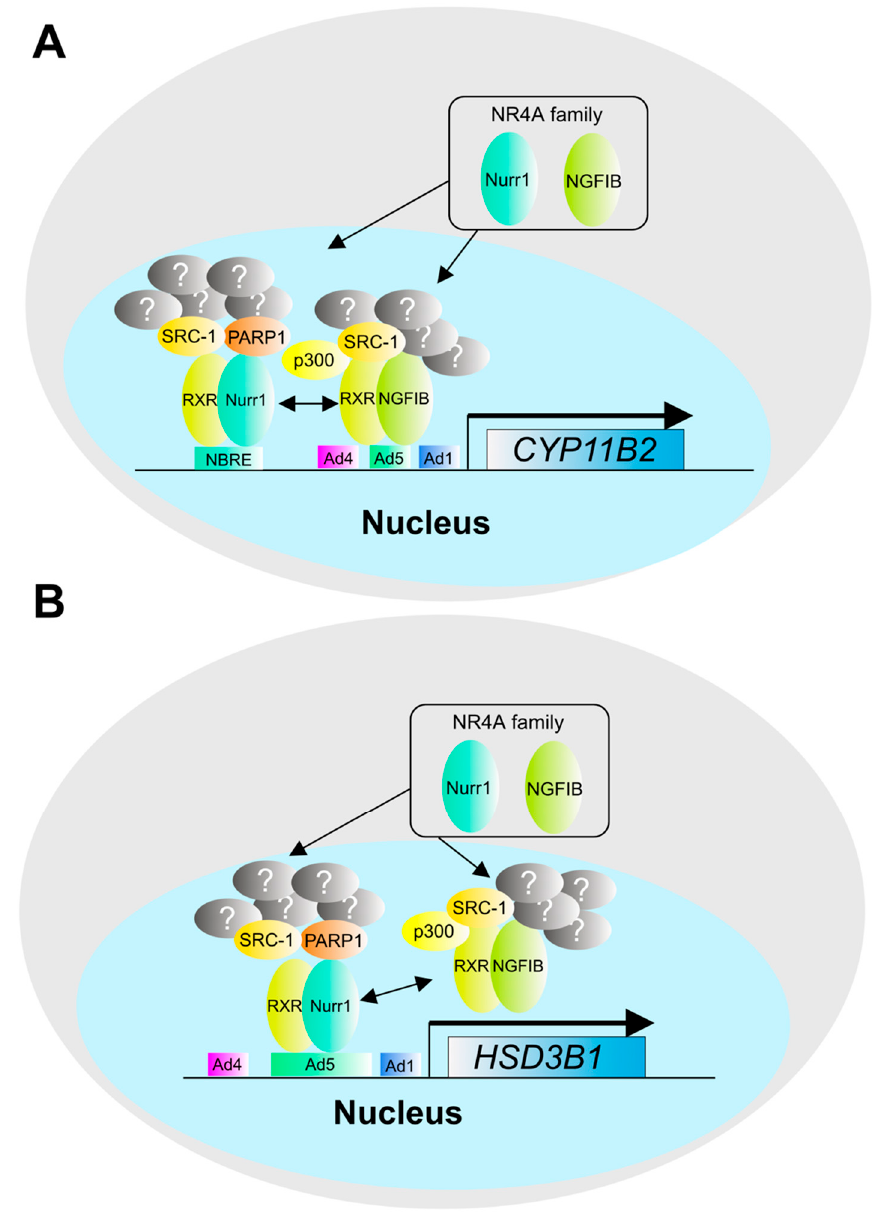
Figure 5. Transcriptional regulation of steroidogenic genes by the NR4A family. The promoter regions of CYP11B2 and HSD3B1 contain NR4A family binding sequences such as NGFIB and Nurr1, which regulate gene expression of CYP11B2 and HSD3B1 by forming a transcription factor complex. ( A ) Gene expression of CYP11B2 by NR4A family. ( B ) Gene expression of HSD3B1 by NR4A family. Although p300, SRC-1, and PARP1 have been reported as components of the complex, other components are still unknown.